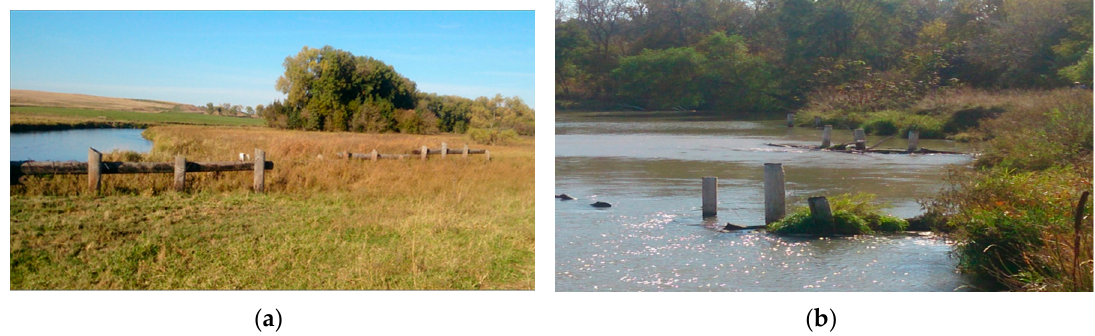
Figure 3. Jetties installed in 1950 at Site 5 ( a ) and in 2000 at Site 4 ( b ). Note the sediment that has accumulated over time in front of the jetties installed in 1950.